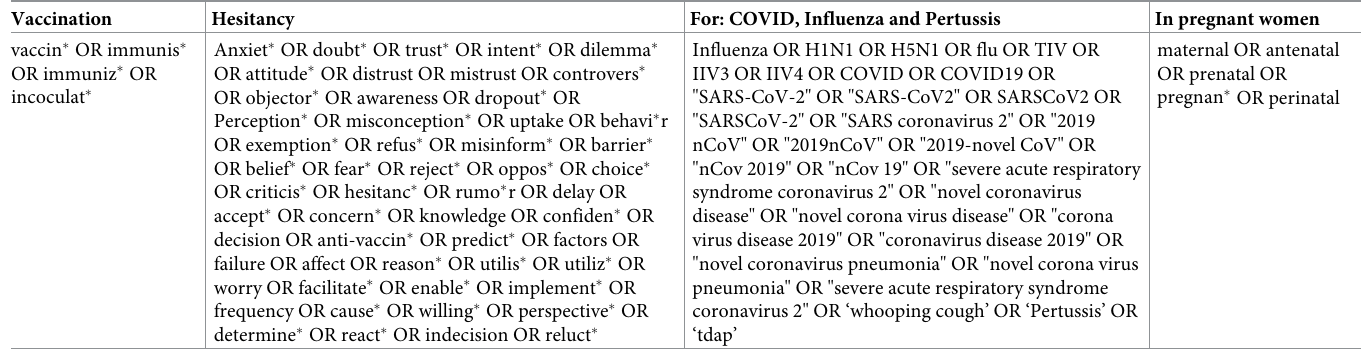
Table 1. A summary of the search strategy, each column was divided by the Boolean operator ‘AND’ during the search. Vaccination